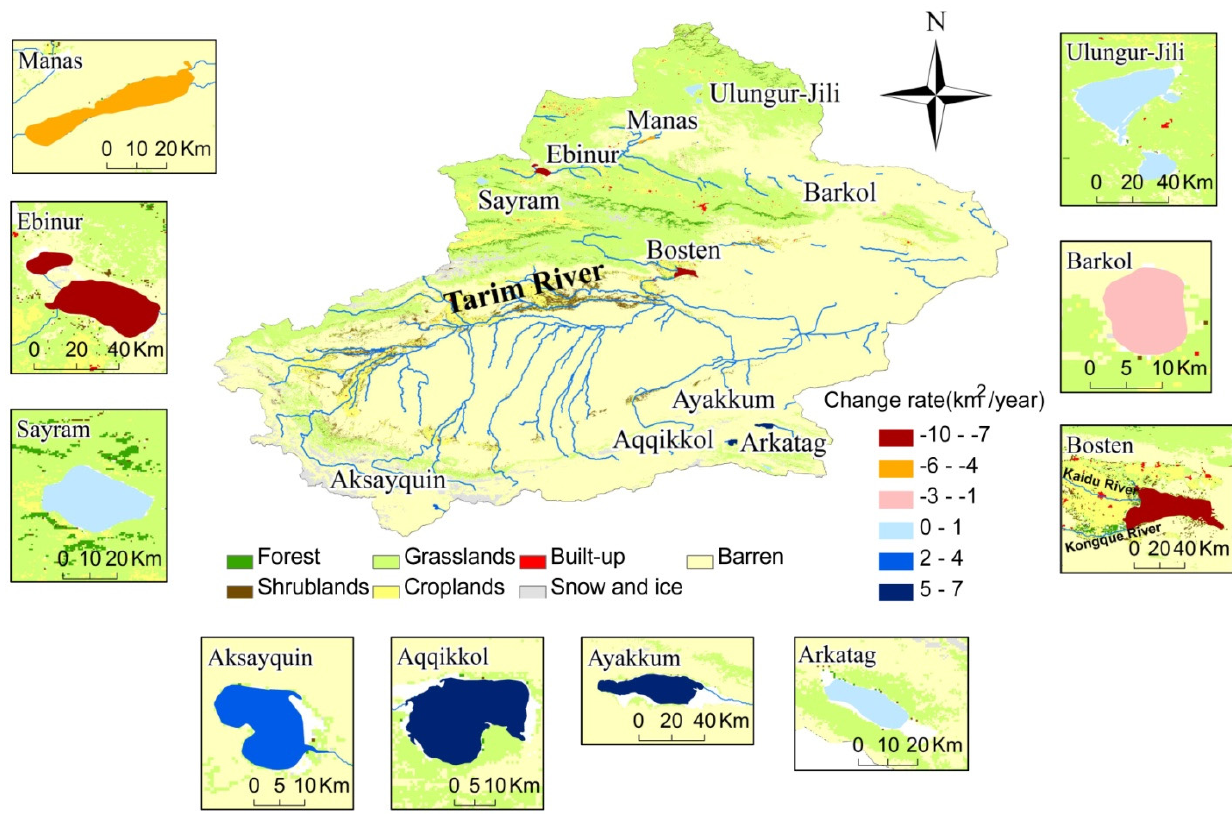
Figure 6. Changing trends and rates in the surface area of major lakes in XUAR in July from 2001 to 2014. Spatial distribution of land cover/use types was extracted from MODIS land cover type product in 2012